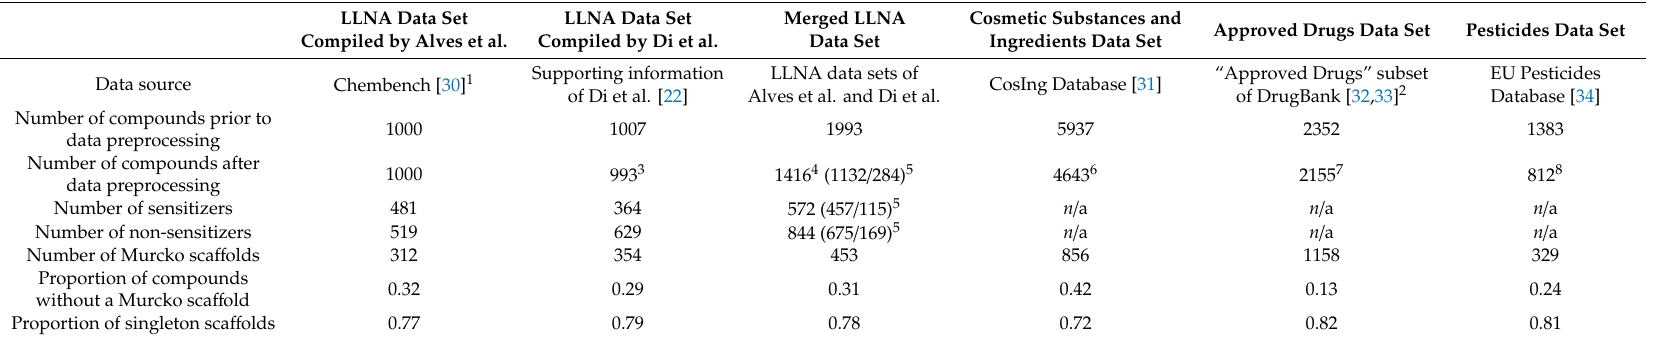
Table 1. Overview of all data sets used in this work.